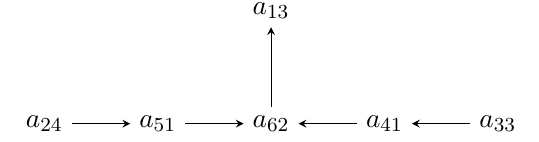
Figure 9. The initial cluster of Conf 7 ( P 3 ) does not have the topology of an E 6 Dynkin diagram but it is possible to mutate it to one which does. This cluster contains homogenised A -coordinates of all six types given in